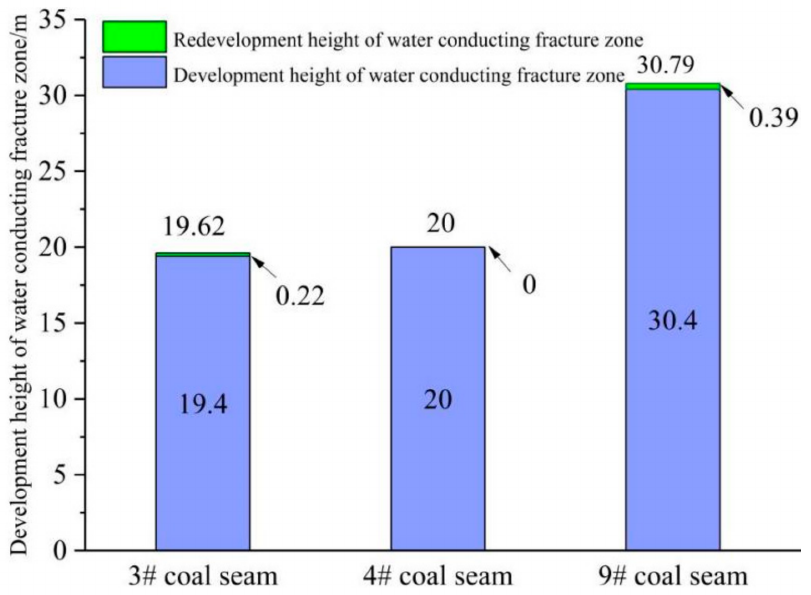
Figure 23. Redevelopment of and change in the water-carrying fracture zone in the old goaf.